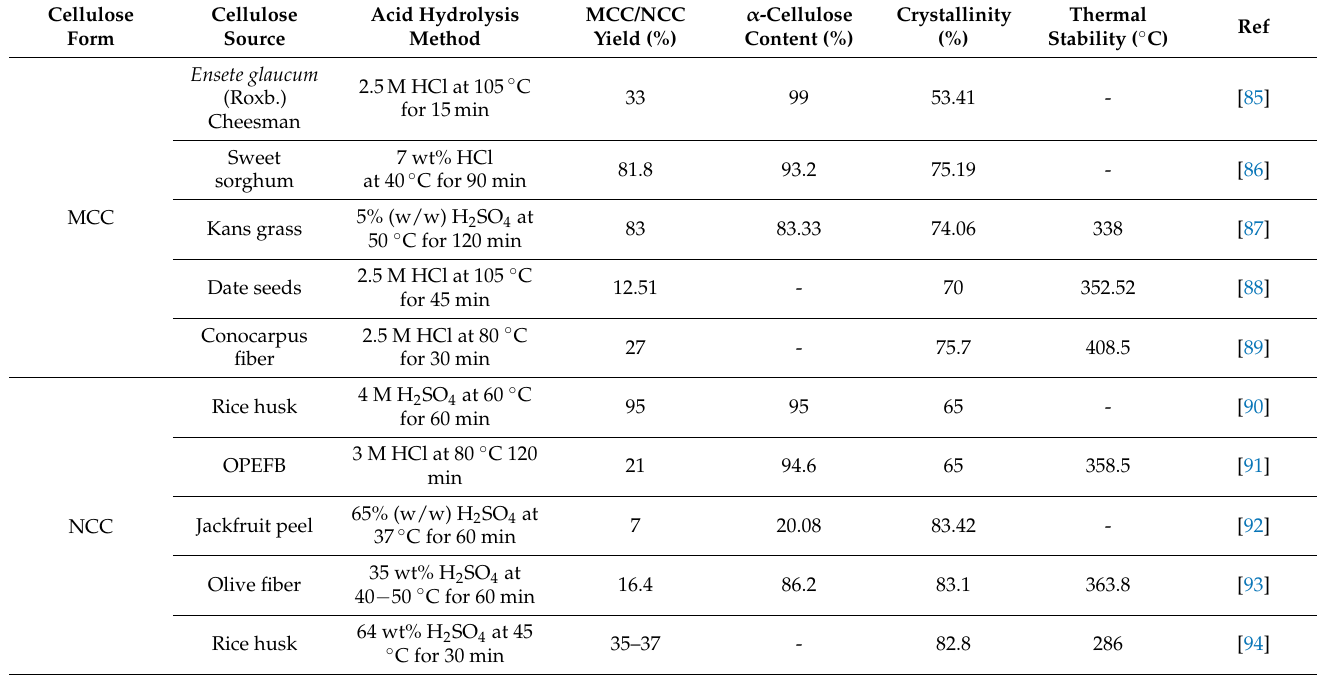
Table 1. Preparation of MCC and NCC from various sources using different acid hydrolysis